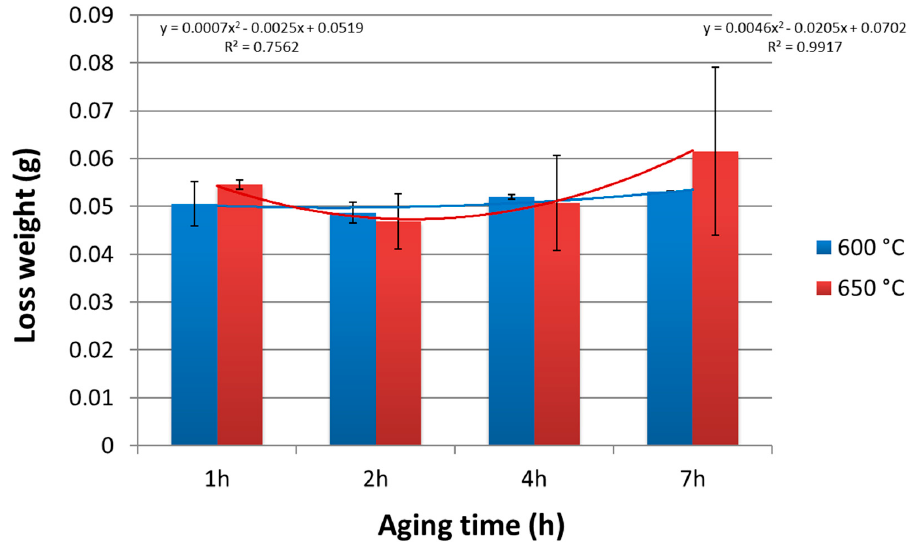
Figure 3. Comparison of tribological wear resistance of the CuNi2Si1 alloy solution heat-treated and aged for 1, 2, 4 and 7 h at 600 °C and 650 °C.